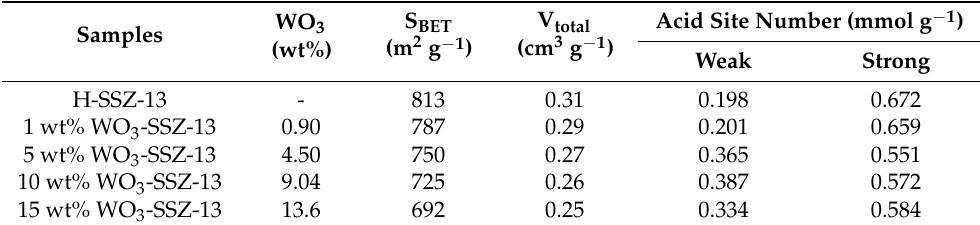
Table 1. Physicochemical properties of the H-SSZ-13 and WO 3 -SSZ-13 samples.